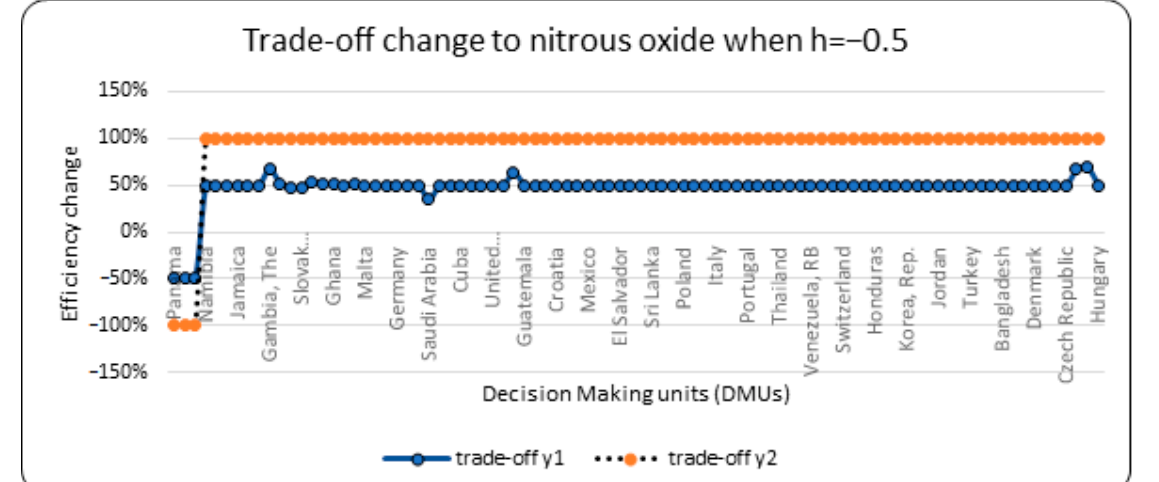
Figure 4. Trade-off effects on the nitrous oxide emissions ( 𝑧 (cid:2870)(cid:3029) ), when ℎ = −0.5 . Since we applied the same trade-off program with same trade-off margin (i.e., ℎ = ±0.5 ) to each desirable-output ( 𝑦 (cid:2869)(cid:3034) and 𝑦 (cid:2870)(cid:3034) ) to see the efficient change in each undesirable- output ( 𝑧 (cid:2869)(cid:3029) and 𝑧 (cid:2870)(cid:3029) ), we established at each step that trade-off in 𝑦 (cid:2869)(cid:3034) produced a better result in all four experiments above. Out of the four experiments, two experiments of trade-off ℎ = +0.5 produced more efficient results among undesirable-outputs ( 𝑧 (cid:2869)(cid:3029) and 𝑧 (cid:2870)(cid:3029) ), see Figures 1 and 3. Now, if we compare it with the original emission values of me- thane 𝑧 (cid:2869)(cid:3029) and nitrous oxide 𝑧 (cid:2870)(cid:3029) , we can authenticate that trade-off point at ℎ = +0.5 is the optimal trade-off point to achieve indirect efficiency, see Figure 5. There is an improve- ment in almost all the inefficient countries except those with zero change (Algeria, Angola, and Argentina, etc.). There are no deficiencies to the unchanged DMUs, either they were already at the efficient frontier or below the frontier line. Figure 5 shows the change in